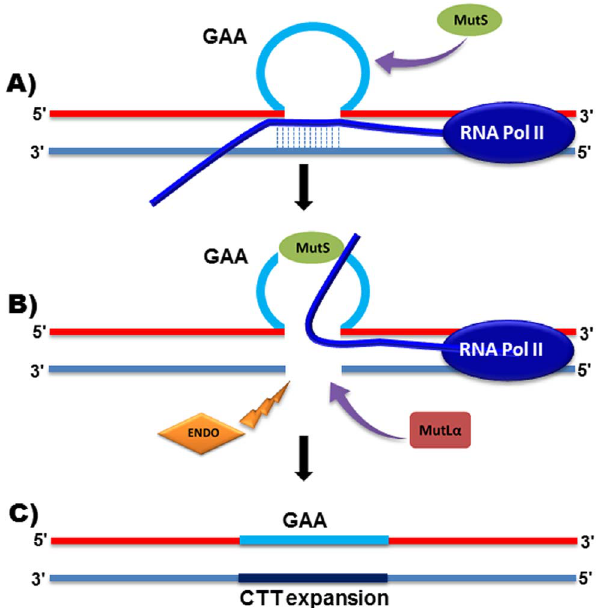
Figure 6. Proposed mechanism of MMR action on intergene- tional GAA repeat expansions. Schematic images representing: ( A ) a small loop caused by triplex DNA structure; ( B ) recognition of the loop by the MutS complex, cleavage with endonuclease (ENDO), opening of the loop, recruitment of MutL a and synthesis of expanded DNA, and ( C ) end of repair by ligation of the further expanded strand and release of MMR proteins.